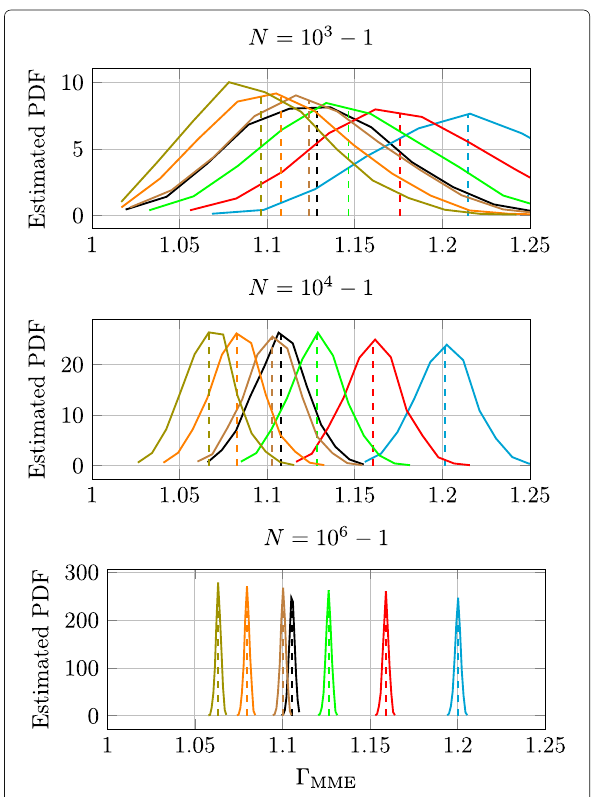
Fig. 3 Estimated probability density function for receiver correlation ( p = 2, Q = 0) and different N . Noise correlation factor (cid:9) η max = 0.05. Solidlines represent the histograms, while dashedlines depict the means. The H 0 case result is shown in black , while the H 1 case results are colored , where the SNR from right to left is given by {− 10, − 11, ... , − 15 }